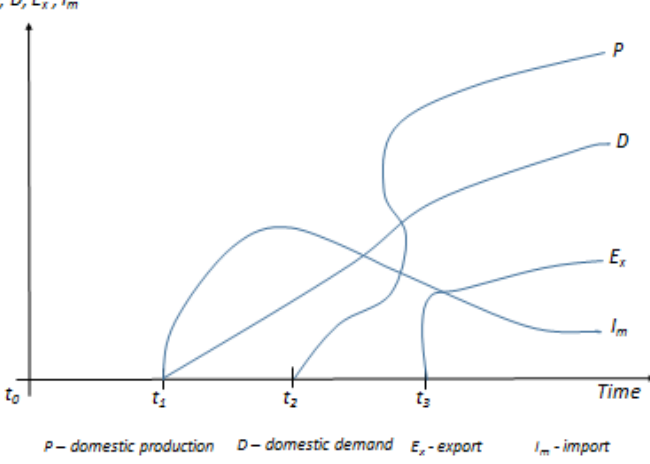
Figure 1. The flying geese formation model of a product cycle. Source: authors’ original work, based on Misala (2005). International Exchange and the Global Economy, PWN Warsaw.